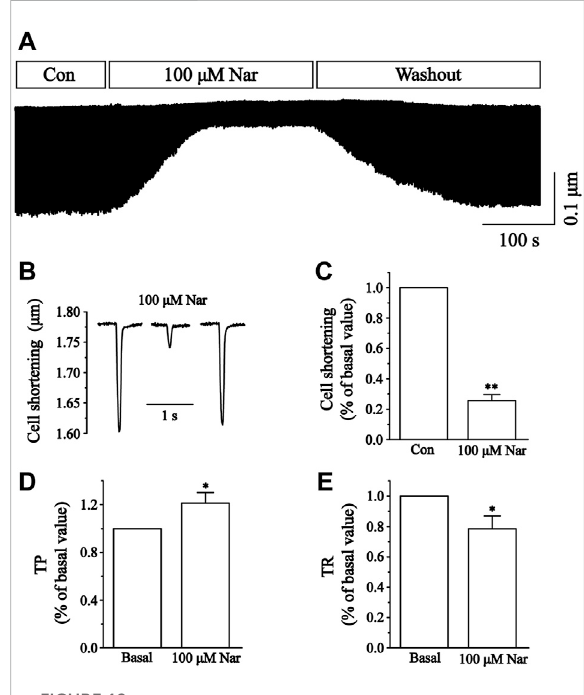
FIGURE 12 EffectsofNaronCa 2+ contractioninisolatedcardiomyocytes and time parameters of cell shortening. (A) Recordings of cardiomyocyte contraction on time course under the Con, Nar (100 μ M) and washout conditions. (B) Single typical recordings of cell shortening at Con, Nar (100 μ M) and washout. (C) Summarized data at Con and Nar (100 μ M). Values were expressed as the mean ± SEM. Each group has 9 cells from fi ve rat hearts. ## p < 0.01 vs. Con group; ** p < 0.01 vs. Con group. (D,E) Summarized data of TP and TR at Con and Nar (100 μ M). Values were expressed as the mean ± SEM (n = 6 cells). Each group has 6 cells from threerat hearts. # p < 0.05 vs.Basal; * p < 0.05vs.